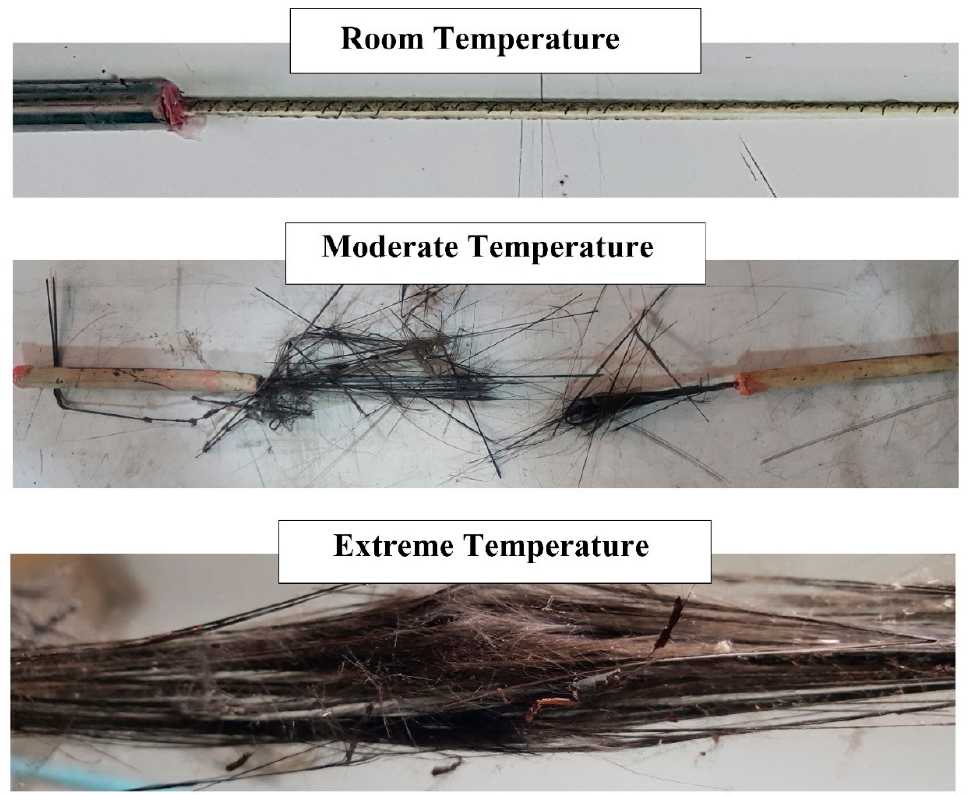
Figure 2. Typical failure modes of FRP reinforcing bars after exposure to elevated temperatures.